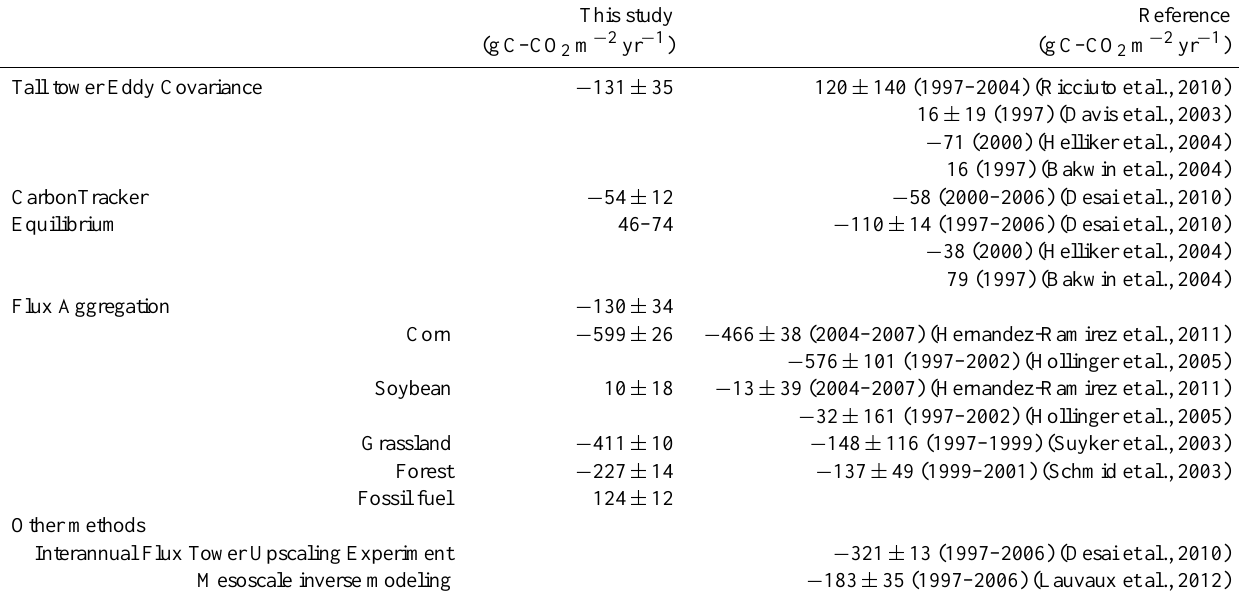
Table 2. A summary of annual net ecosystem exchange estimated from different methods. Net ecosystem exchange in the Reference column is from the study in the Midwest, USA in recent years. Negative fluxes indicate carbon sink from the atmosphere and positive fluxes indicate carbon release to the